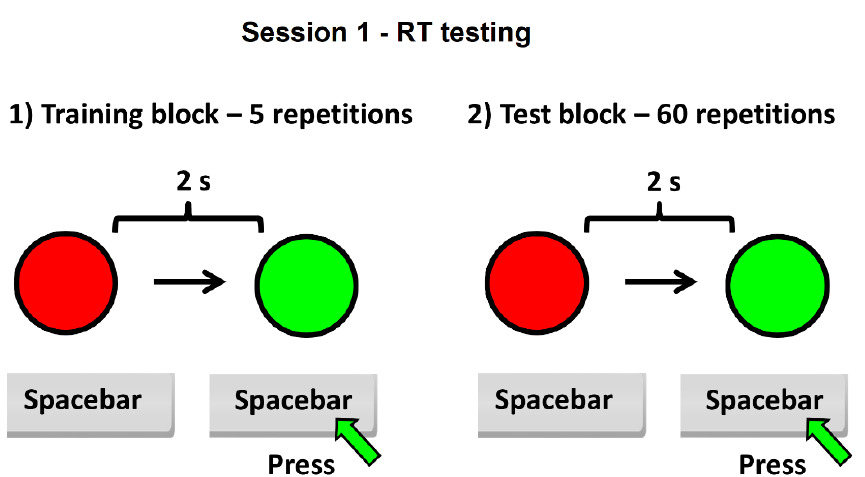
Figure 1. Schematic of the session 1 of the experiment—RT testing.